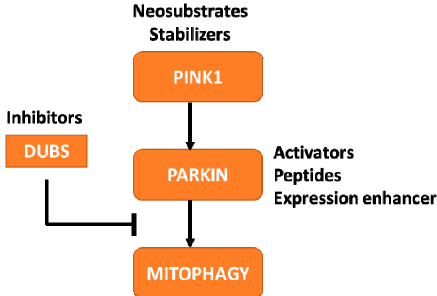
Figure 2. Therapeutic approaches to increase PINK1-Parkin mediated mitophagy. The schematic indicates the proteins within the pathway that are currently being targeted for developing PD therapies, along with the therapeutic approach being pursued.